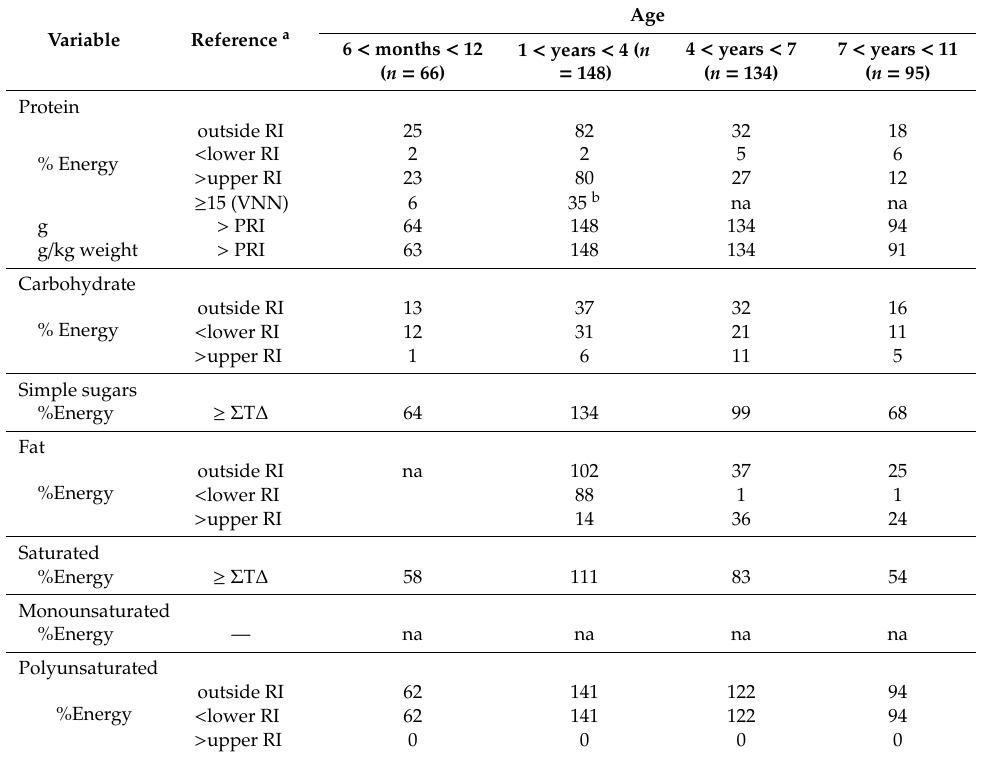
Table 7. Number of infants / children who exhibited a daily intake of macronutrients outside the reference RI range and / or above the reference PRI and / or STD value, by